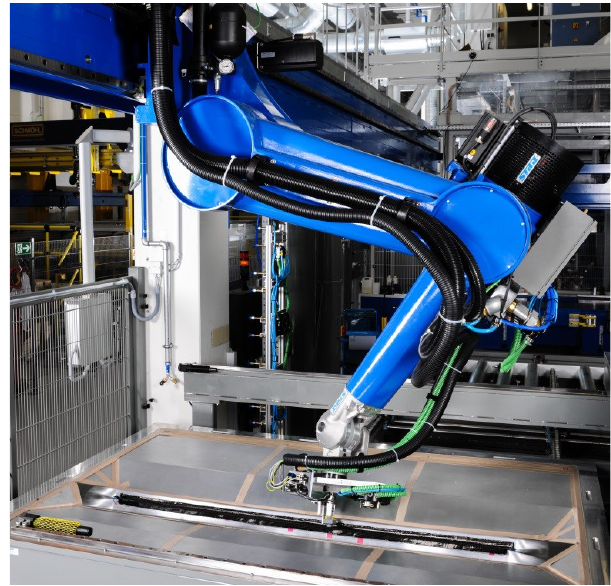
Figure 6: Eddy current